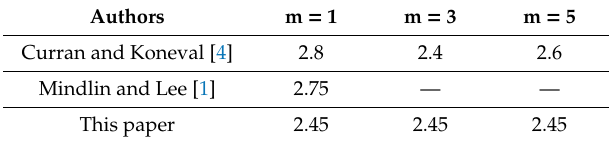
Table 1. Comparisons of Bechmann’s Numbers from Di ff erent